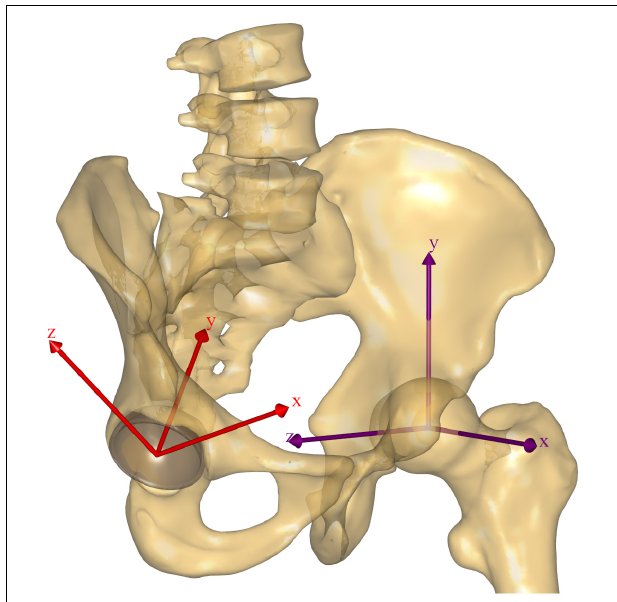
FIGURE 3 | The pelvis-based reference frame according to ISB recommendations is reported in purple for the left hip, while the acetabular reference frame is reported in red for the right hip. The latter is aligned with the acetabular opening plane for the decomposition of the HCF vector; its origin is coincident with the HJC, the y axis is perpendicular to the acetabular opening plane, and the x axis is oriented to the anterior (+)/posterior (–) direction, while the z axis is oriented to the superolateral direction (+) and passes through the mid-acetabular notch (–). The idealized hemisphere used to calculate the intersection of the HCF vector on the acetabulum is illustrated for the right hip in light